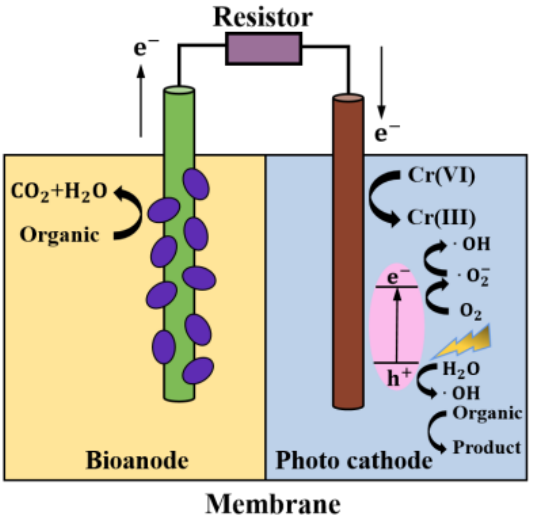
Figure 5. Bioanode coupling photo-cathode for organics oxidation and Cr(VI) reduction.